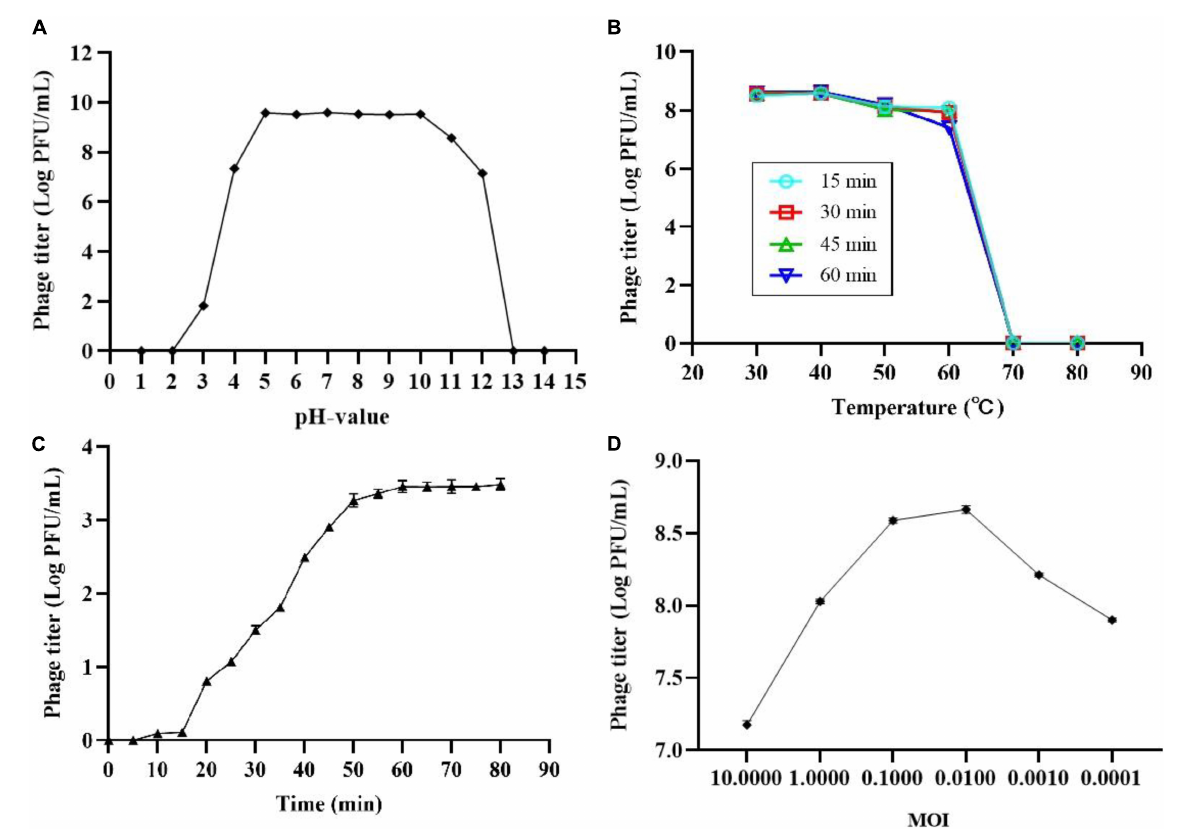
FIGURE1 Biological characterization of phage SL01. (A) pH stability of SL01. (B) The optimal multiplicity of infection. (C) One-step growth curve of SL01. (D) The optimal multiplicity of infection.